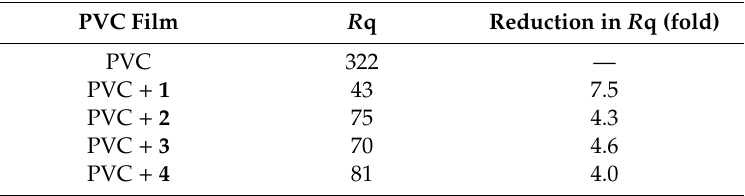
Figure 8. AFM images for PVC films after irradiation (300 h): ( a ) PVC (blank), ( b ) PVC + 1 , ( c ) PVC + 2 , ( d ) PVC + 3 , and ( e ) PVC + 4 . Table 5. R q values for PVC films after